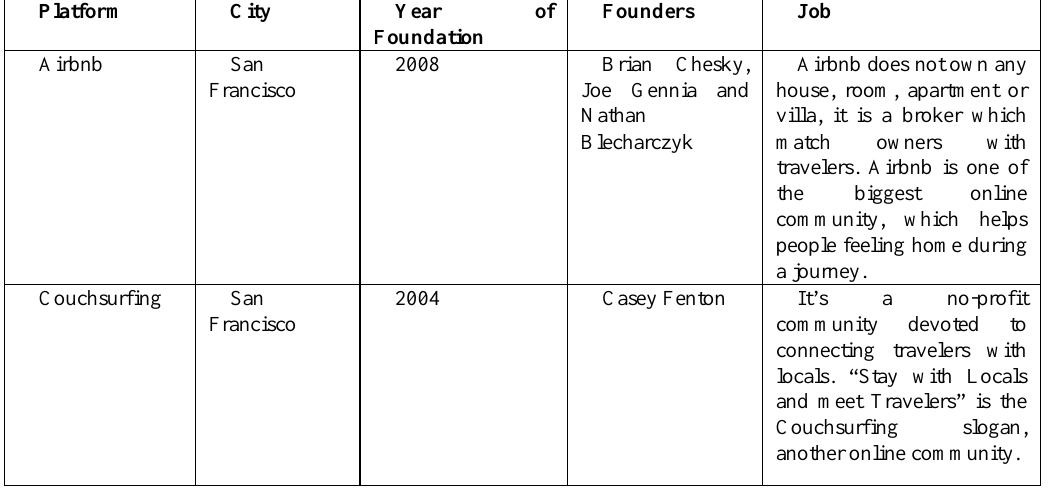
Table 1: Description of the Platforms